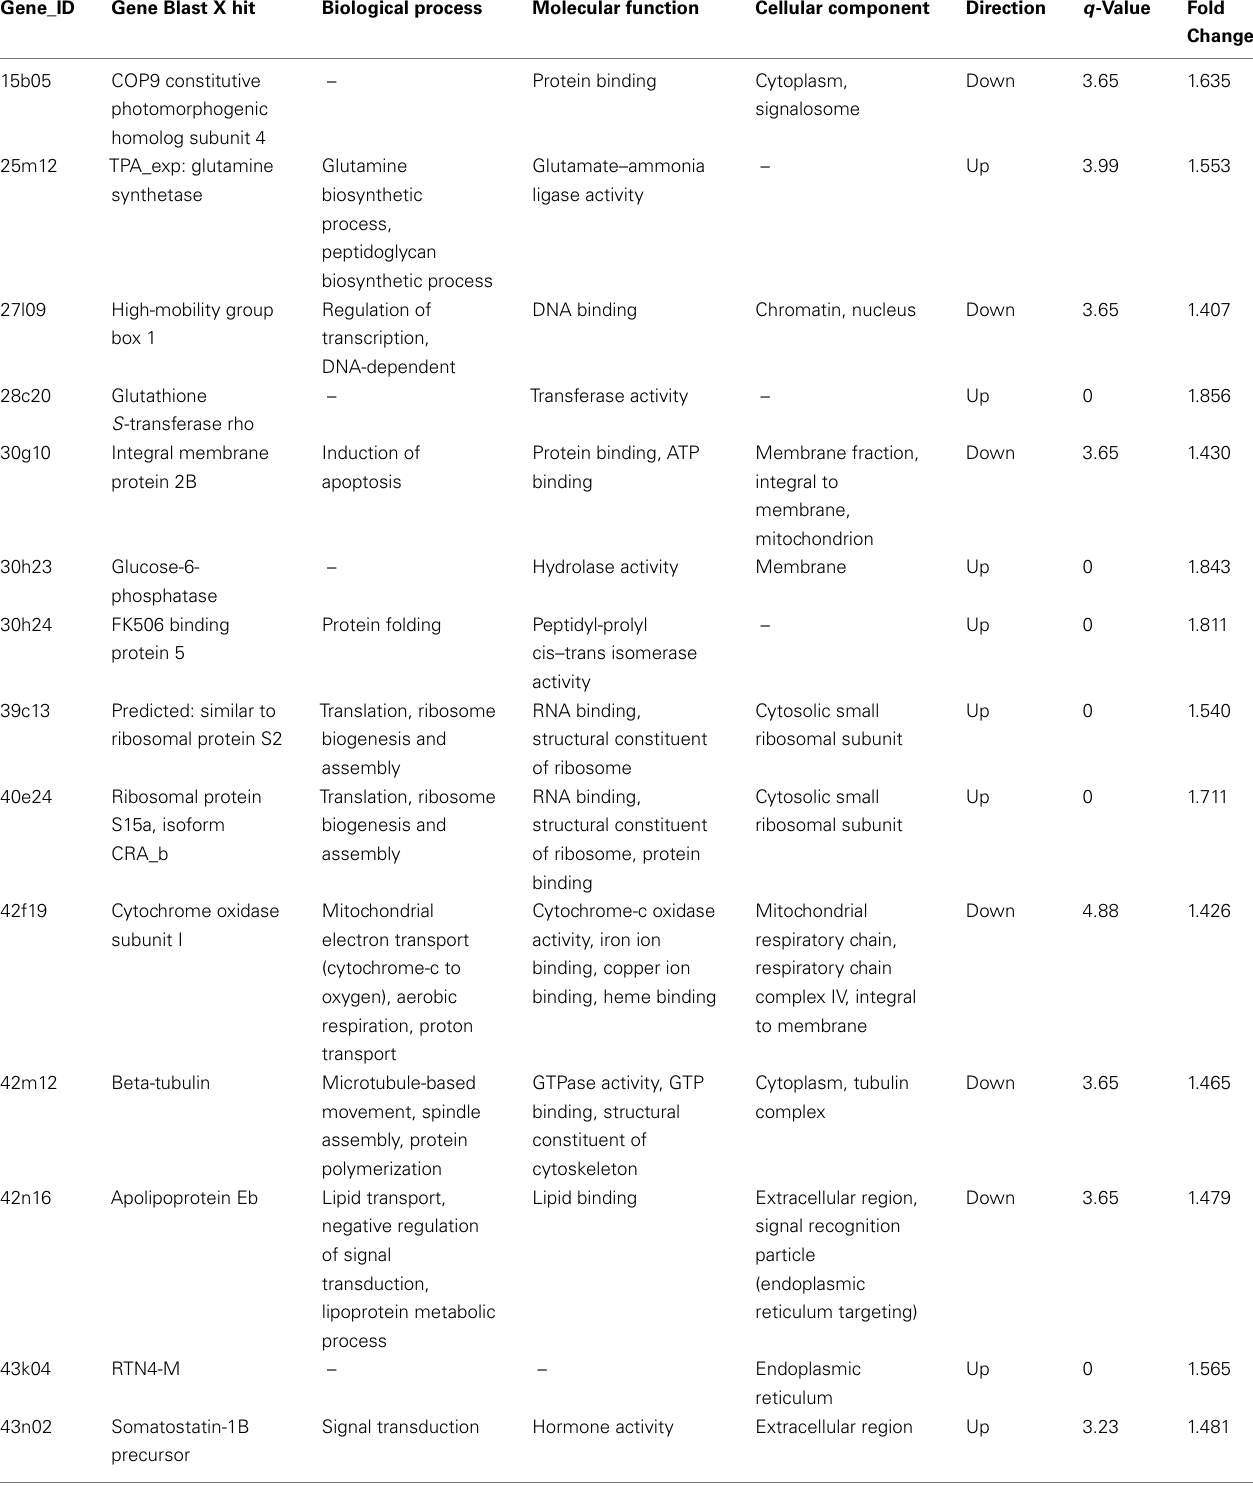
TableA1 | Multilevel gene ontology classifications of transcripts expressed in male goldfish liver identified by version 1.1 of the goldfish-carp cDNA microarray to be affected by